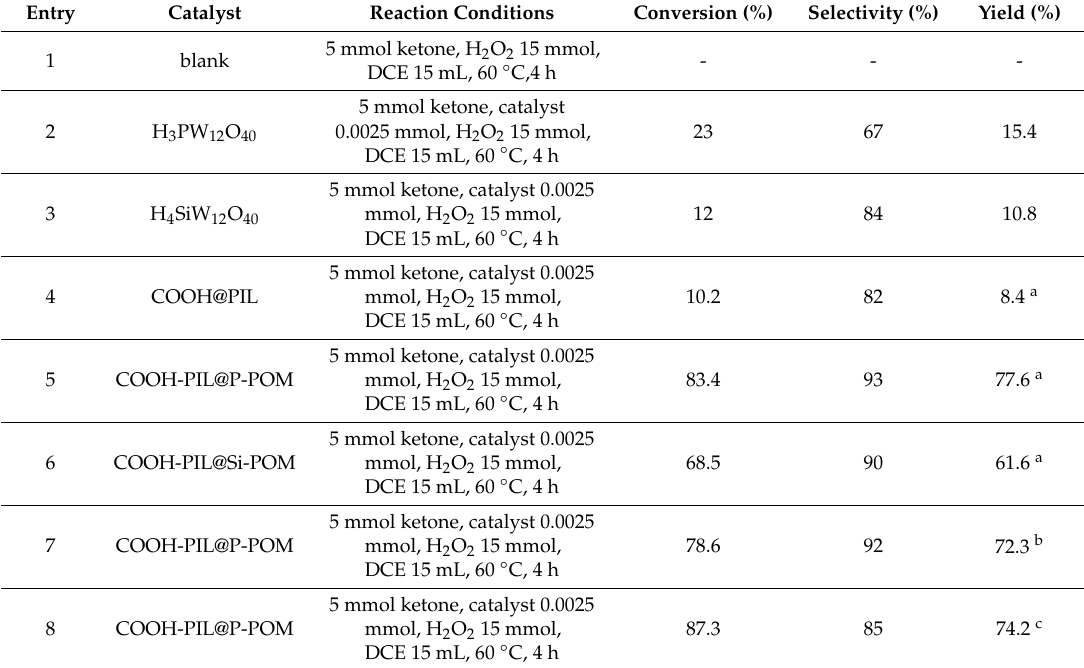
The catalytic performance of various catalysts in Baeyer–Villiger (BV) oxidation of cyclohexanone with H 2 O 2